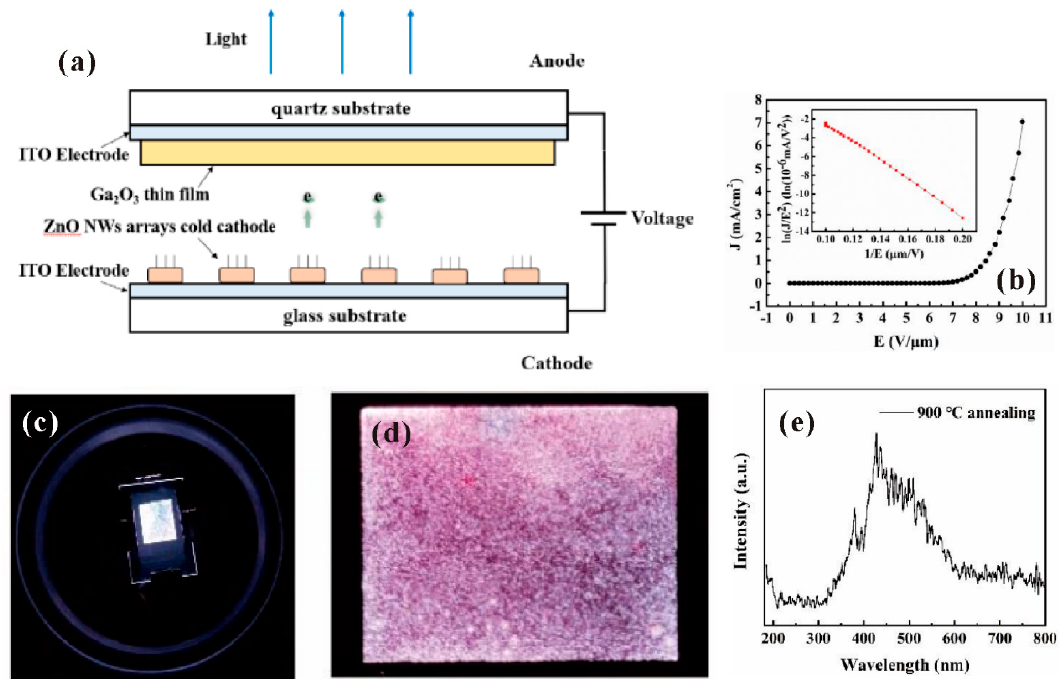
Figure 33. Demonstration of an ultraviolet (UV) light source based on ZnO nanowires cold cathode. ( a ) Schematic diagram of the device. ( b ) Field-emission characteristics. ( c ) Optical image of the operating device. ( d ) Emission pattern. ( e ) Cathodoluminescent spectrum. Reproduced from [108], with the permission of IEEE, 2020.